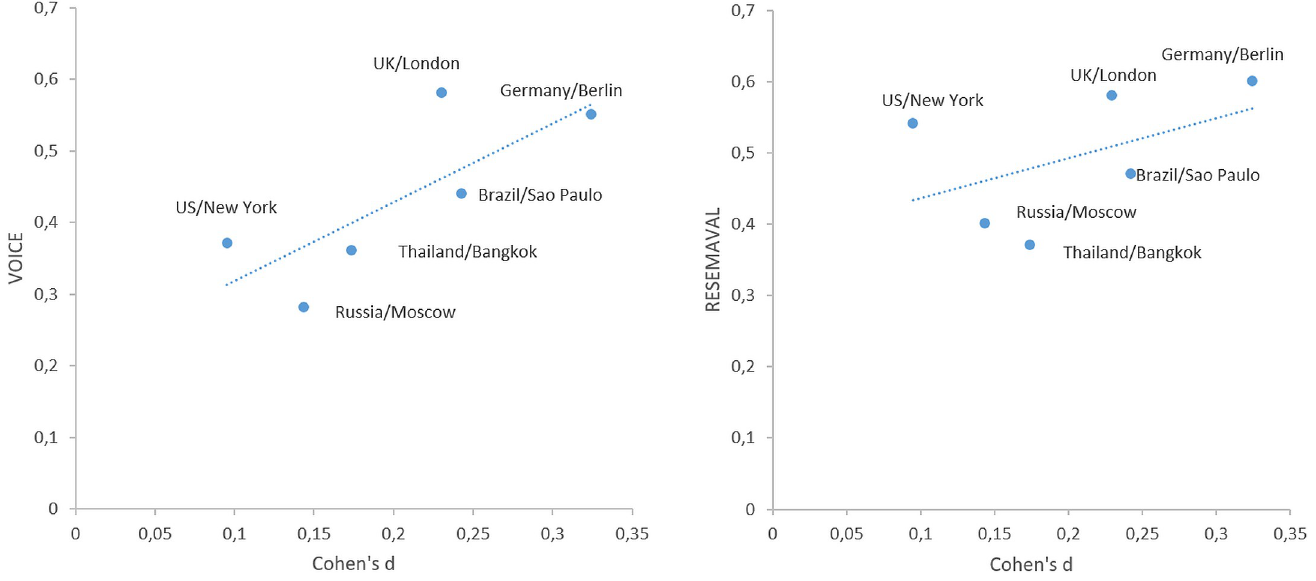
Fig 1. Scatter plots for face-ism Cohen’s d and WVS index RESEMAVAL and VOICE.